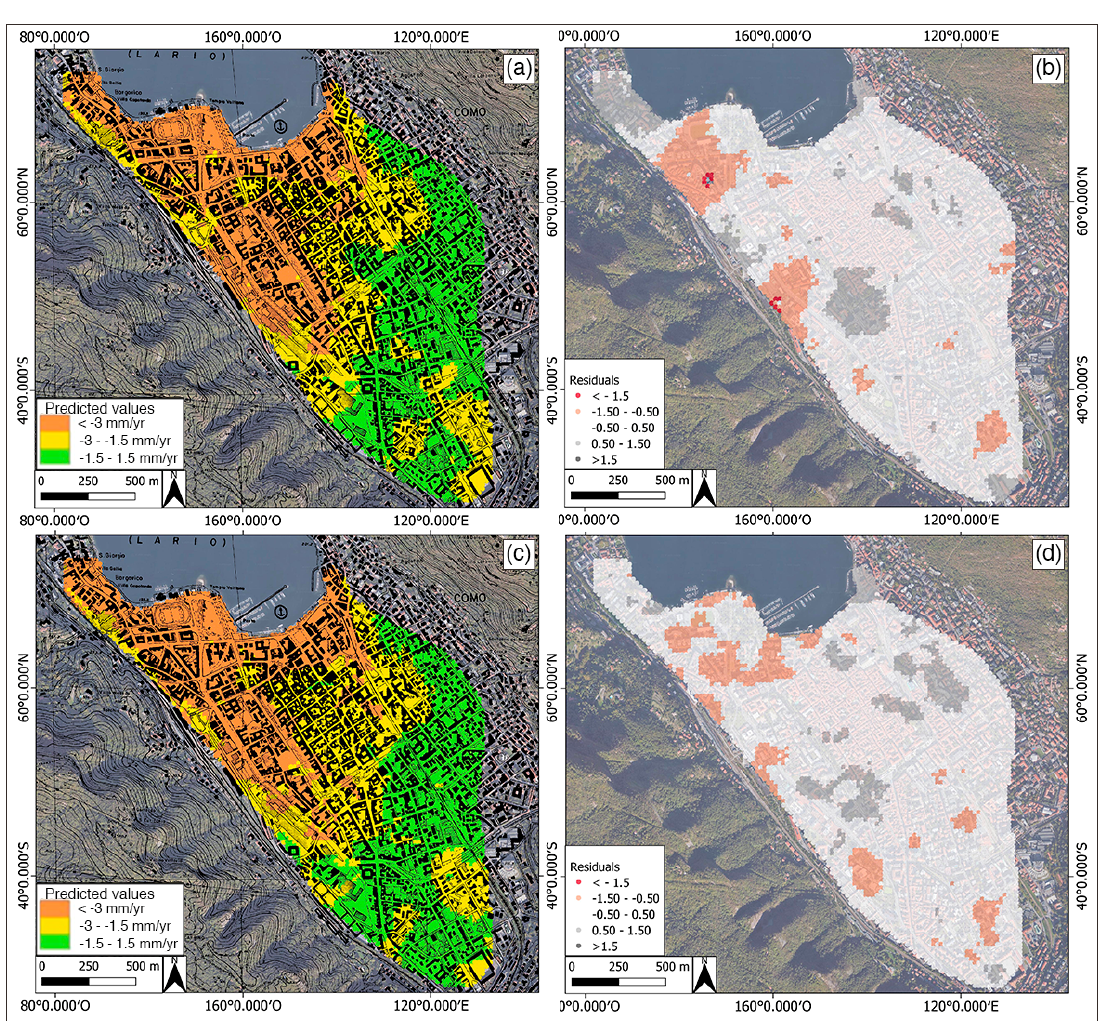
Figure 6. Results of the best GAM regression analysis using the thicknesses of unit 1 (RM) and unit 3 (OS), overburden stress ( σ v ) value, and piezometric level as predictors: ( a ) predicted values and ( b ) residuals of the modeling of ERS 1 and 2 (1992–2000); ( c ) predicted values and ( d ) residuals of Envisat (2003–2010) modelling.